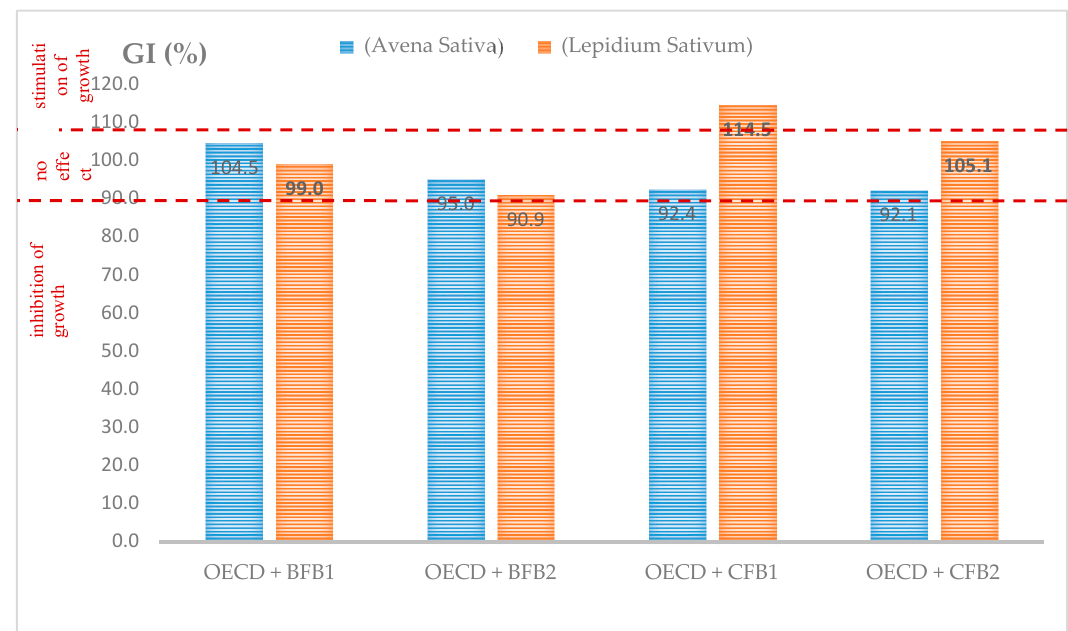
Figure 4. Germination indices for Avena sativa and Lepidium sativum .